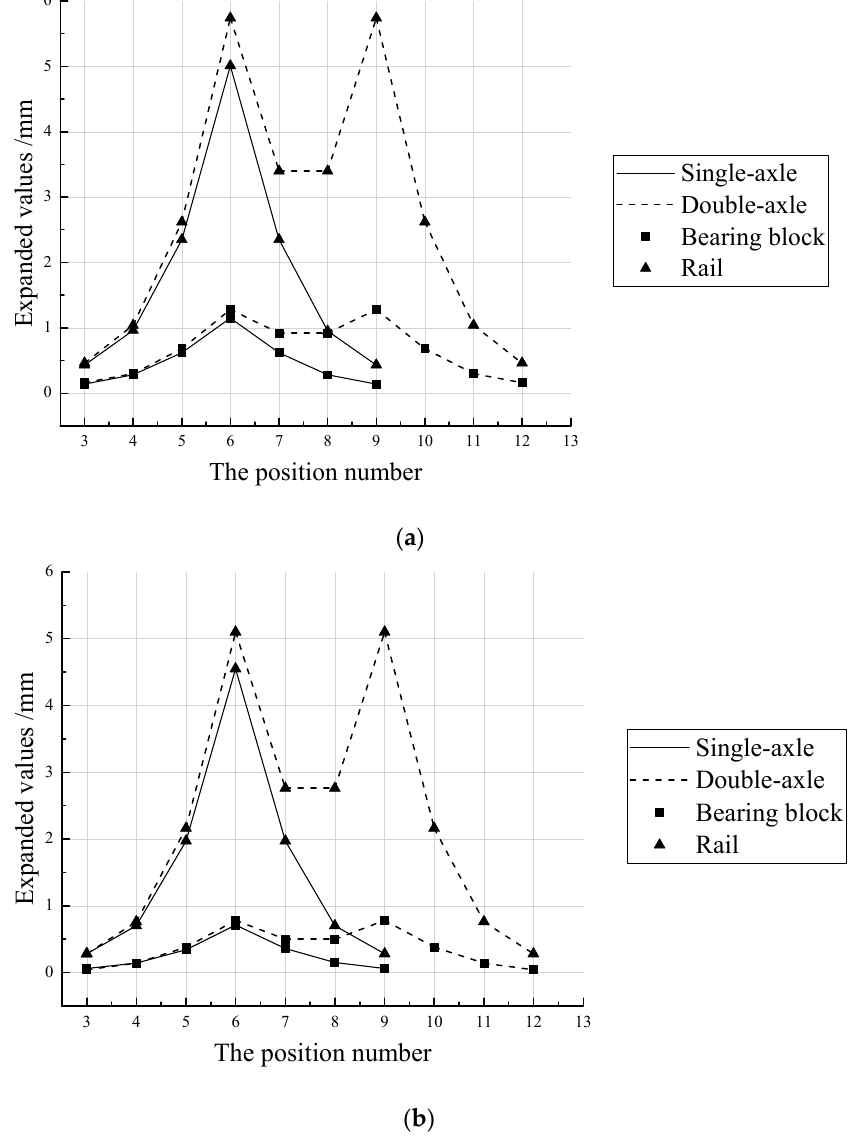
Figure 25. The expansion of the lateral distance of the track gauge and the bearing blocks under the lateral and vertical coupled load. ( a ) TLVT. ( b ) ILVT.